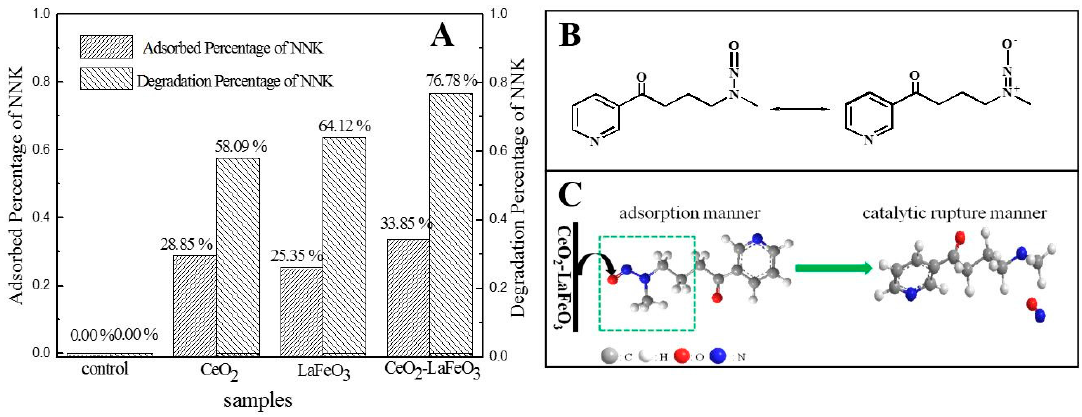
Figure 6. ( A ) Adsorbed and degradation percentage of NNK by CeO 2 , LaFeO 3 and CeO 2 -LaFeO 3 ; ( B ) The resonance structure of NNK; ( C ) The possible adsorption and catalytic rupture manner of NNK on CeO 2 -LaFeO 3 .